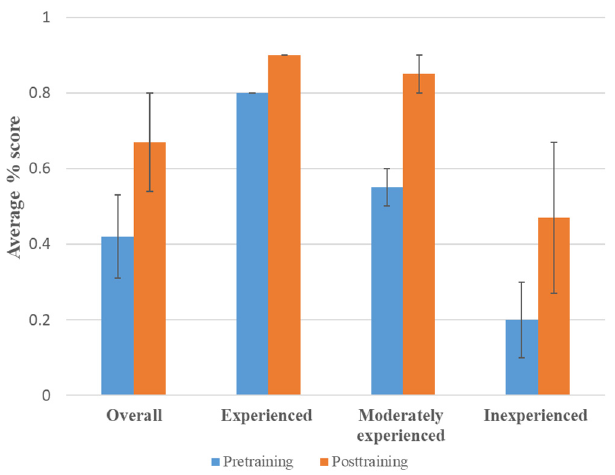
Figure 6. Survey results for pre-training and post-training confidence level of the participants ( n = 6) who participated in the US-guided core needle biopsy.